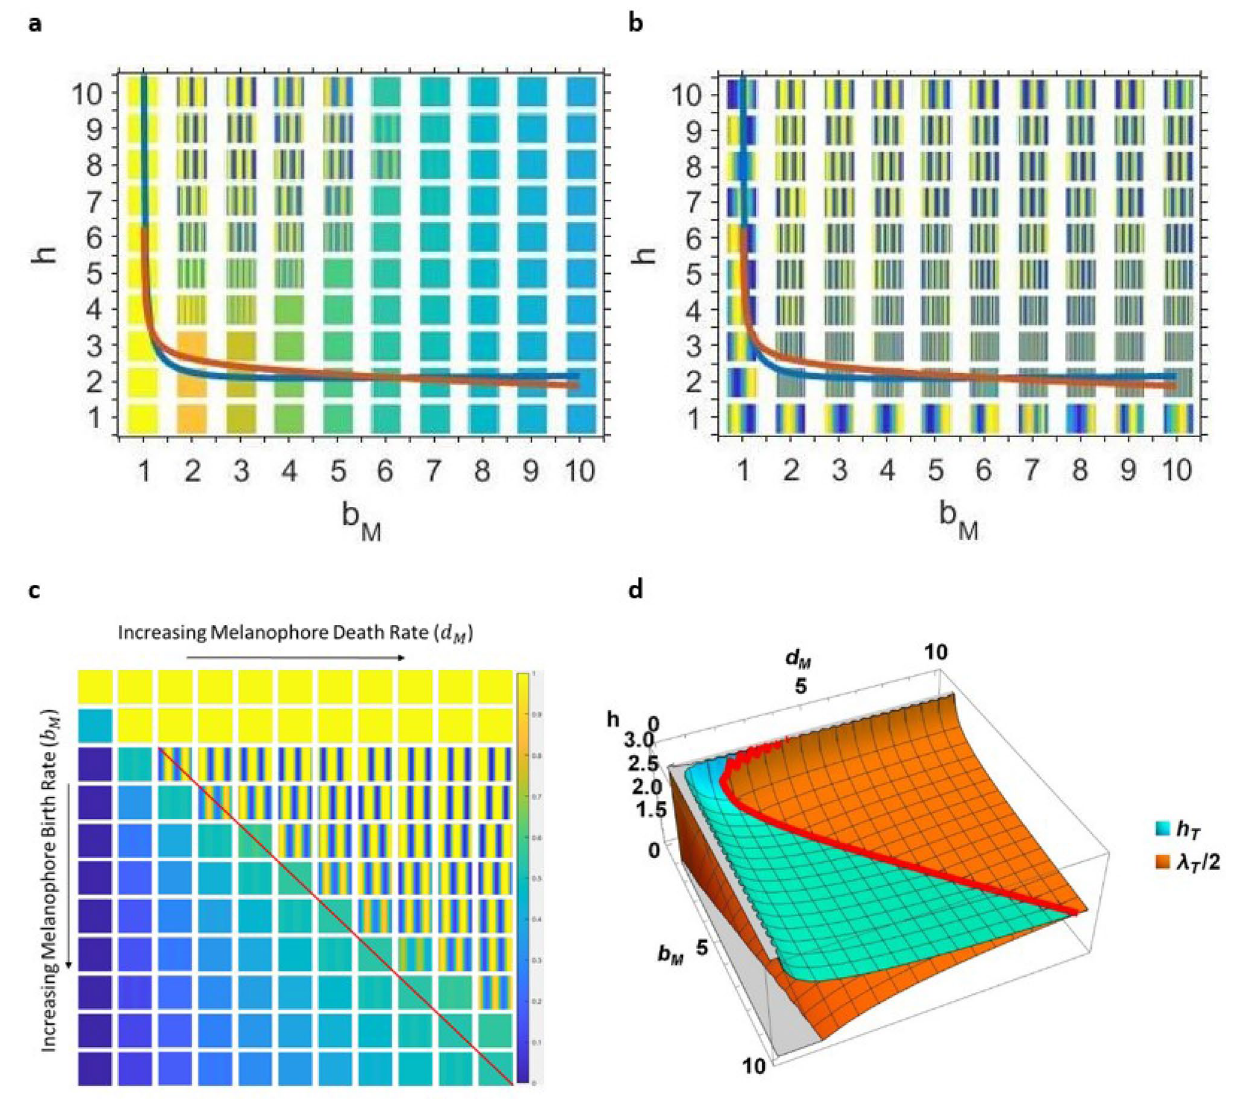
Figure 2. Numerical simulations and results of LSA of the Survival model in one dimension. For each numerical simulation, Eqs. (1) and (2) were simulated on a size n = 50 lattice with periodic boundaries. The xanthophore concentration ( (cid:31) X i (cid:30) ) is shown. The results were extended vertically into a square shape for ease of viewing. The following conditions were held constant in all simulations and when performing the LSA: b X = s = 1 , d X = d MX = 0 . ( a ) and ( b ) Simulations of the Survival model for various long-range interaction distances h and melanophore birth rates b M . The death rate of melanophores was held constant at d M = 4 . The blue curve is a plot of the minimum long-range interaction distance h T that allows for Turing patterns, and the orange curve is one-half of the critical wavelength ( (cid:31) T / 2 ). The simulations in ( a ) and ( b ) are identical, but ( a ) is absolutely scaled between a normalized concentration of zero and one, while ( b ) is relatively scaled between the minimum and maximum values of (cid:31) X i (cid:30) for that simulation. ( c ) Simulations of the Survival model for various b M and d M parameter combinations. For all simulations, the long-range interaction distance was held constant at h = 15 . The red line approximately indicates the onset of patterning at h T = (cid:31) T / 2 . ( d ) Analytical result of LSA of the continuous mean field Eqs. (3)–(4). The cyan surface is a plot of the bifurcation value h T , the critical long- range interaction distance. The orange surface is a plot of half the critical wavelength, (cid:31) T / 2 . The red curve shows the intersection of the two surfaces, where h T = (cid:31) T / 2